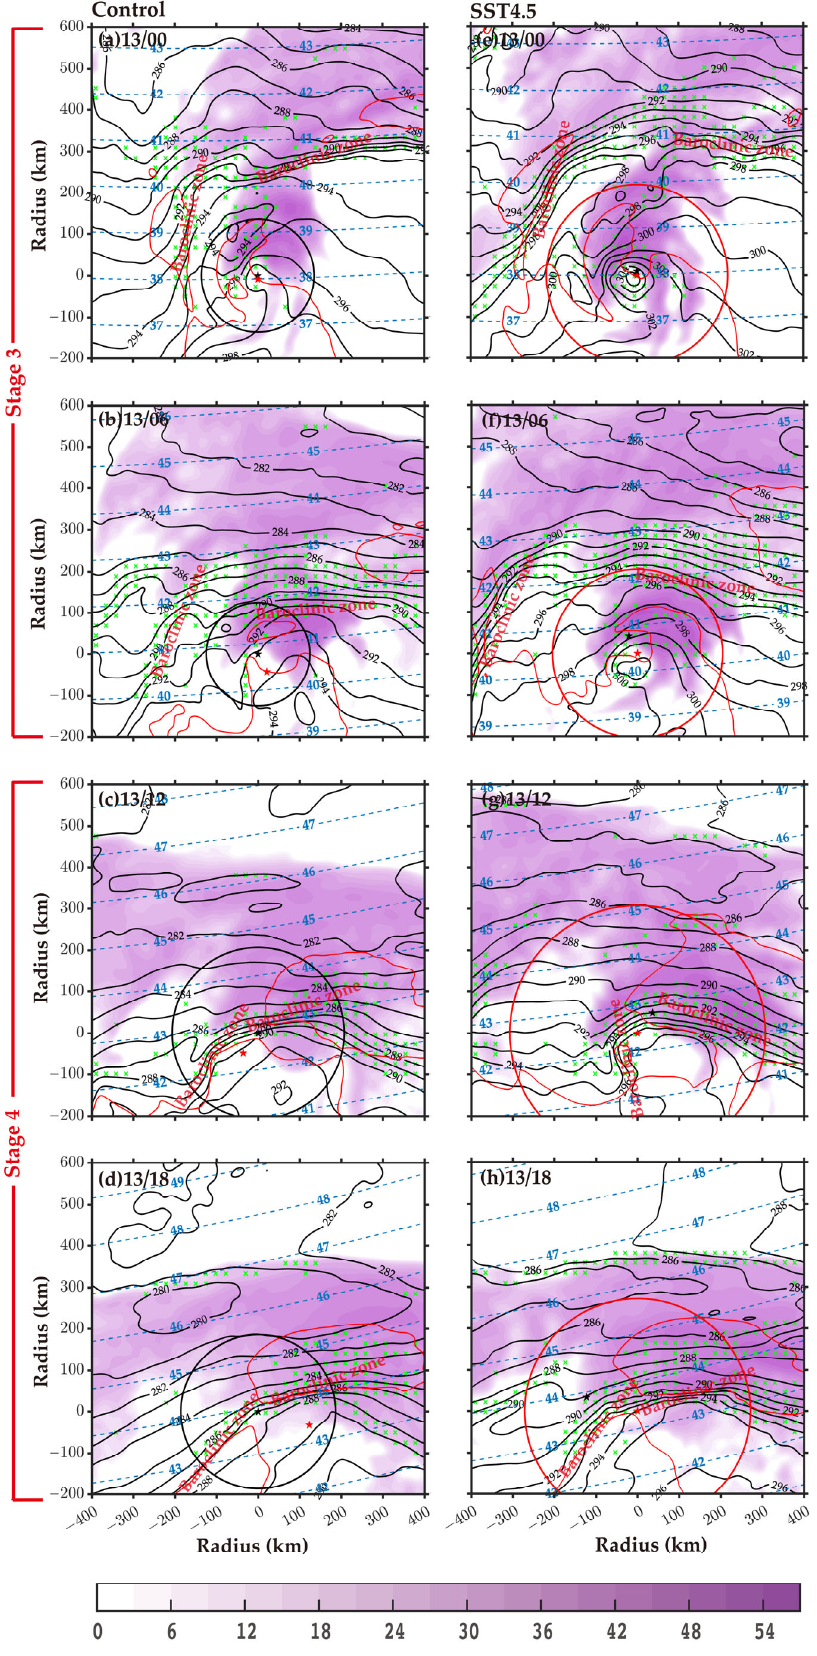
Figure 12. As in Figure 6 but for 13/00, 13/06, 13/12, and 13/18 (stage 3 and stage 4).